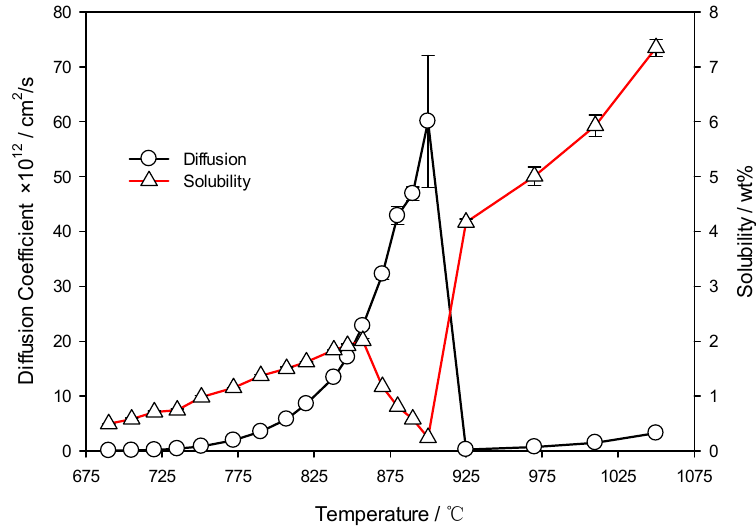
Figure 9. The solubility and diffusion coefficients of Cu in Fe under different temperatures.